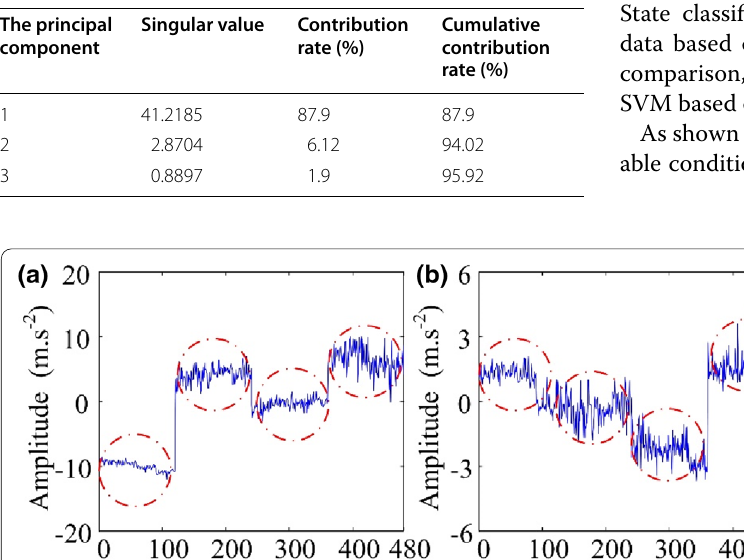
Table 3 The cumulative contribution rate of the principal component